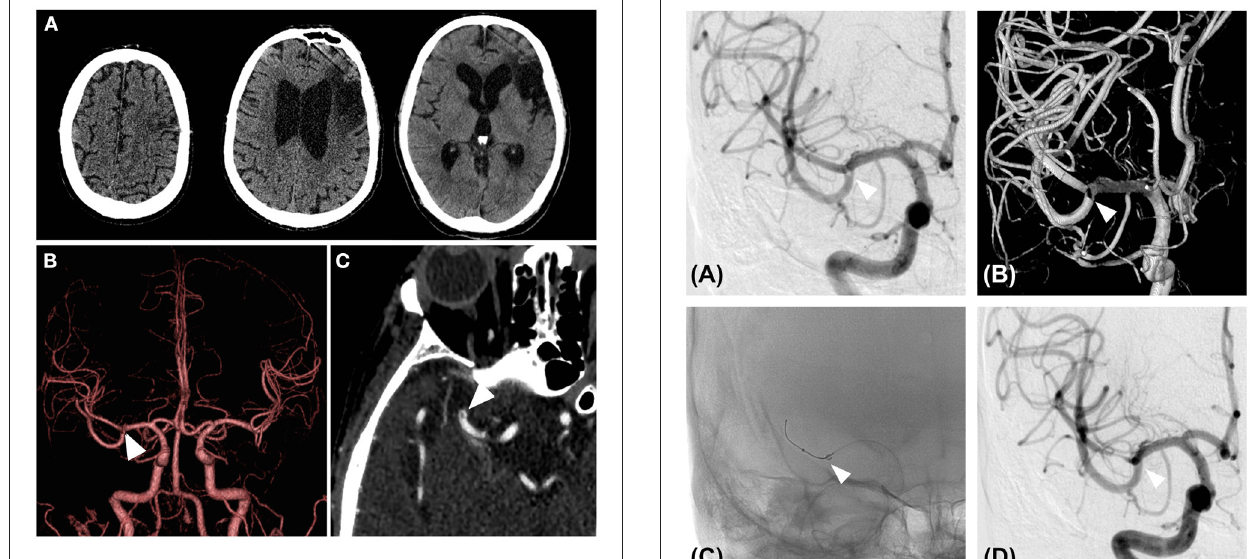
FIGURE 1 | Patient’s cerebral imaging at the time of symptom onset. (A) Computed tomography showed an obsolete infarction of the left frontal lobe, but there were no findings suggestive of hemorrhage or acute infarction on the diseased side. (B) Computed tomography angiography with three-dimensional volume rendering did not exhibit obvious filling defects, but a localized microstenosis was noted in the right middle cerebral artery distal M1 segment (white arrowhead). (C) Subocclusive thrombus in the right middle cerebral artery distal M1 segment (white arrowhead) was found on close observation through the axial image of the computed tomography angiography with maximum intensity projection.